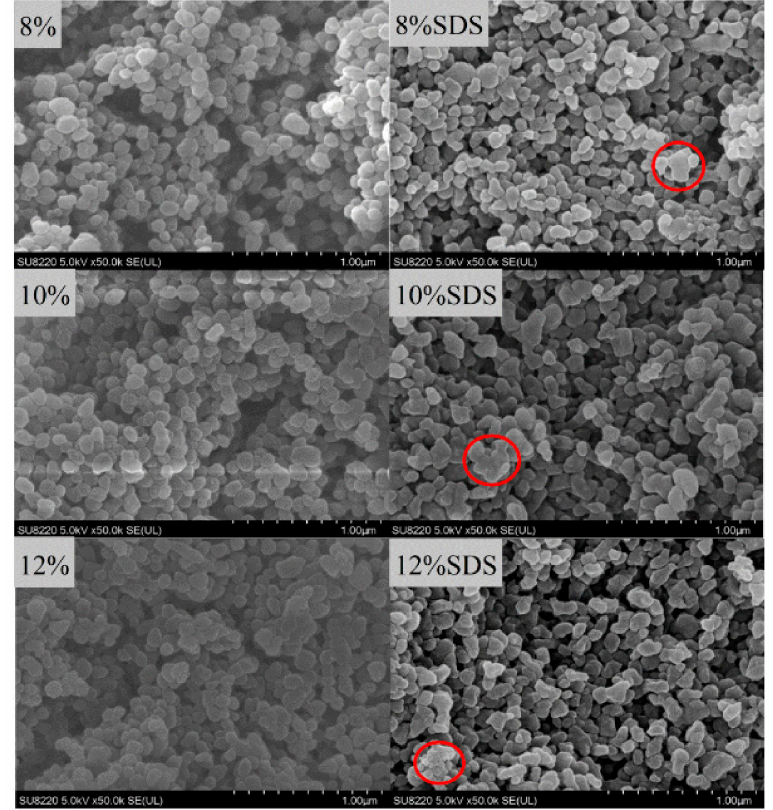
Figure4. TheSEMimagesofGNPscross-linkedby8–12wt%genipinandthecorrespondingSDS-treated GNPs (the large particles are indicated by a red